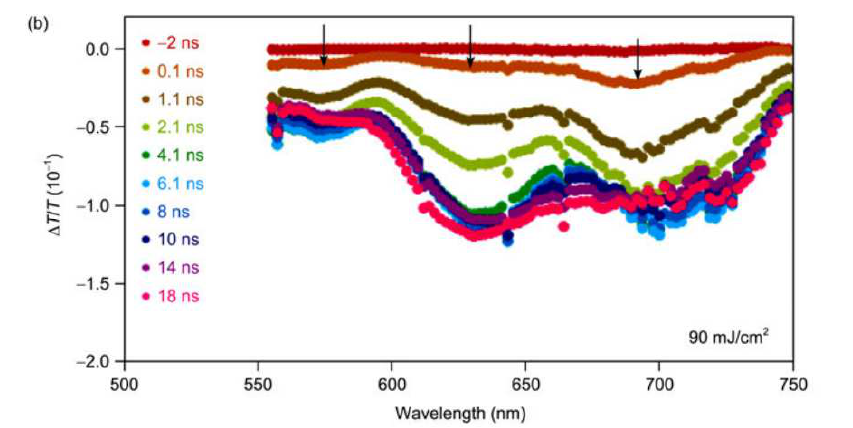
Figure 3. Reverse saturation absorption. Normalized transient transmittance spectra is shown for sub-GOx dispersed in chloro-benzene when the wavelength of pump is 532 nm. In addition, the value of pump fluence is considered as 90 mJ/cm 2 . Reprinted with permission from [10]. Copyright (2012) Chinese Science